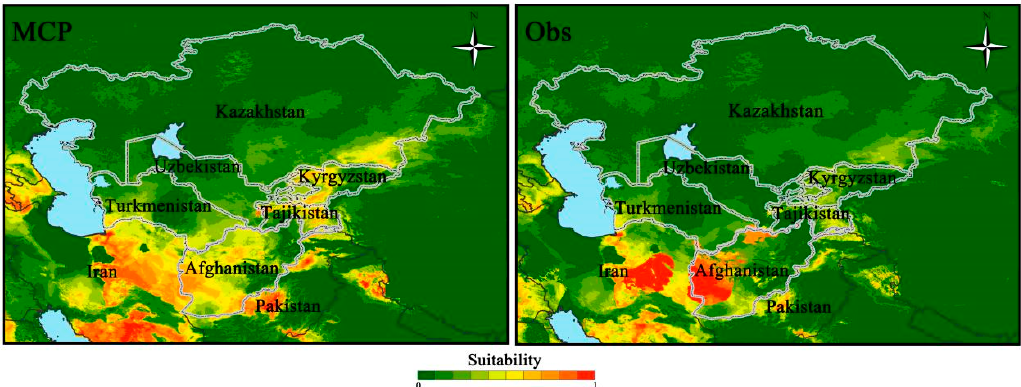
Figure 4. Predicted potential distribution of Spodoptera frugiperda in the Central Asia MCP and Obs models.